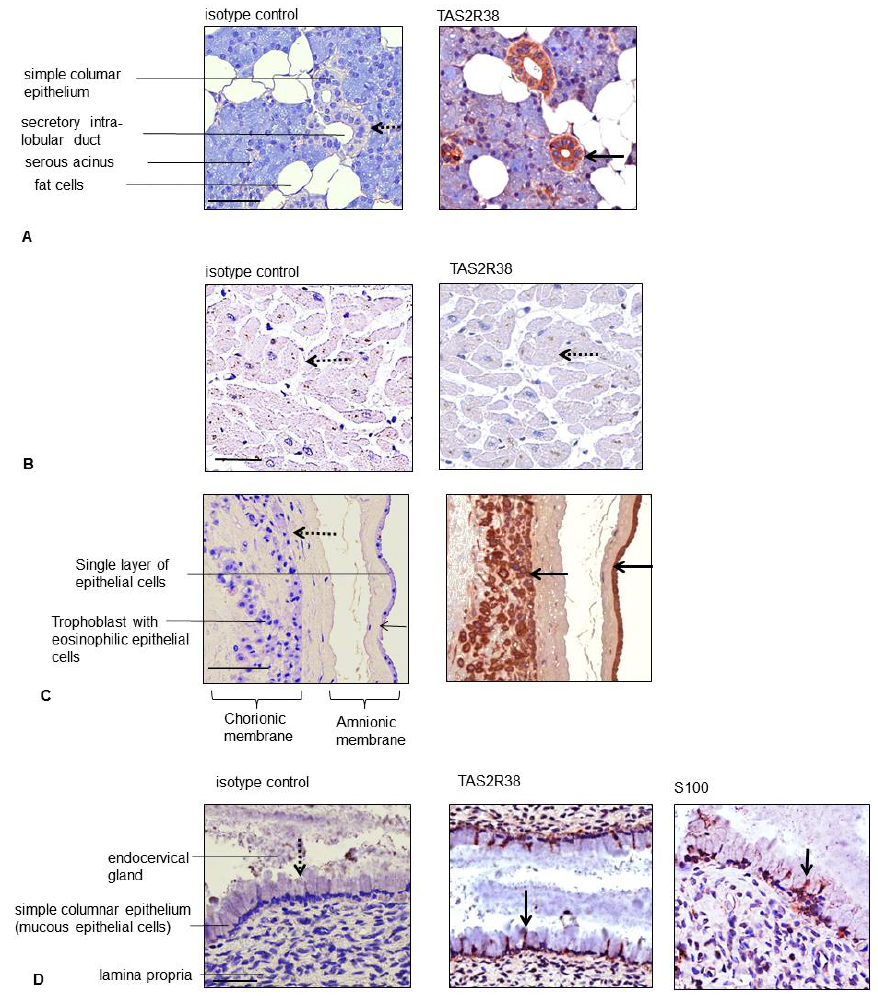
Figure 1. Staining of human tissues of the human tissue microarray against TAS2R38. Parotid gland ( A ); heart ( B ); human placenta (chorionic plate) ( C ) and endocervix ( D ) were stained with an isotype control antibody or an antibody against TAS2R38 and S100 (only the endocervix). Arrows in bold indicate positively and dashed arrows negatively stained cells; the bars correspond to 50 µm.